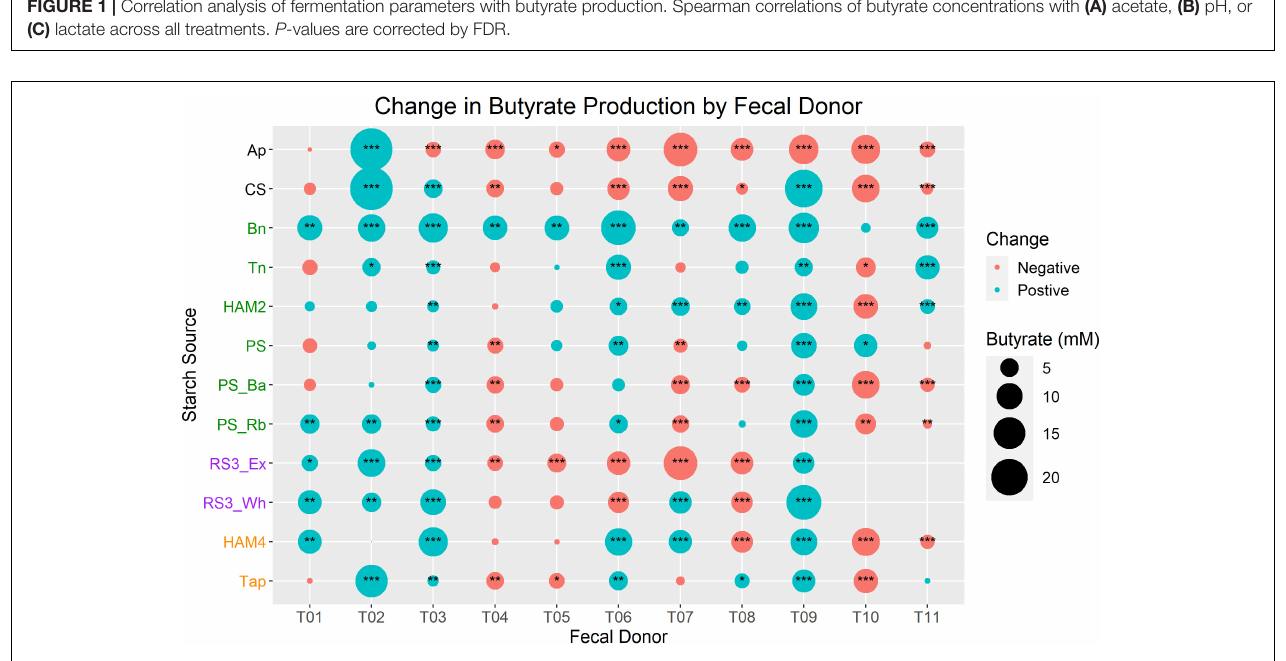
FIGURE 2 | Change in butyrate production between control and treatments by fecal donor. In each case butyrate production during the control fermentation for a given inoculum is subtracted from the butyrate production in a given treatment with that same inoculum. Bubble size is proportional to the total change in butyrate production, colored red for a decrease and blue for an increase. Y -axis labels of starch sources are colored by RS designation. Black is non-RS, green is RS2, purple is RS3, orange is RS4. Statistical significance of the difference is calculated by one-way ANOVA of the ln(x+1) transformed butyrate values and FDR correction of P -values. Labels are * P < 0.05, ** P < 0.01, *** P < 0.001. Ap, amylopectin; CS, corn starch; Bn, green banana flour; Tn, tiger nut flour; HAM2, high amylose maize starch; PS, potato starch; PS_Ba, potato starch with fecal samples supplemented with Bifidobacterium adolescentis ; PS_Rb, potato starch with fecal